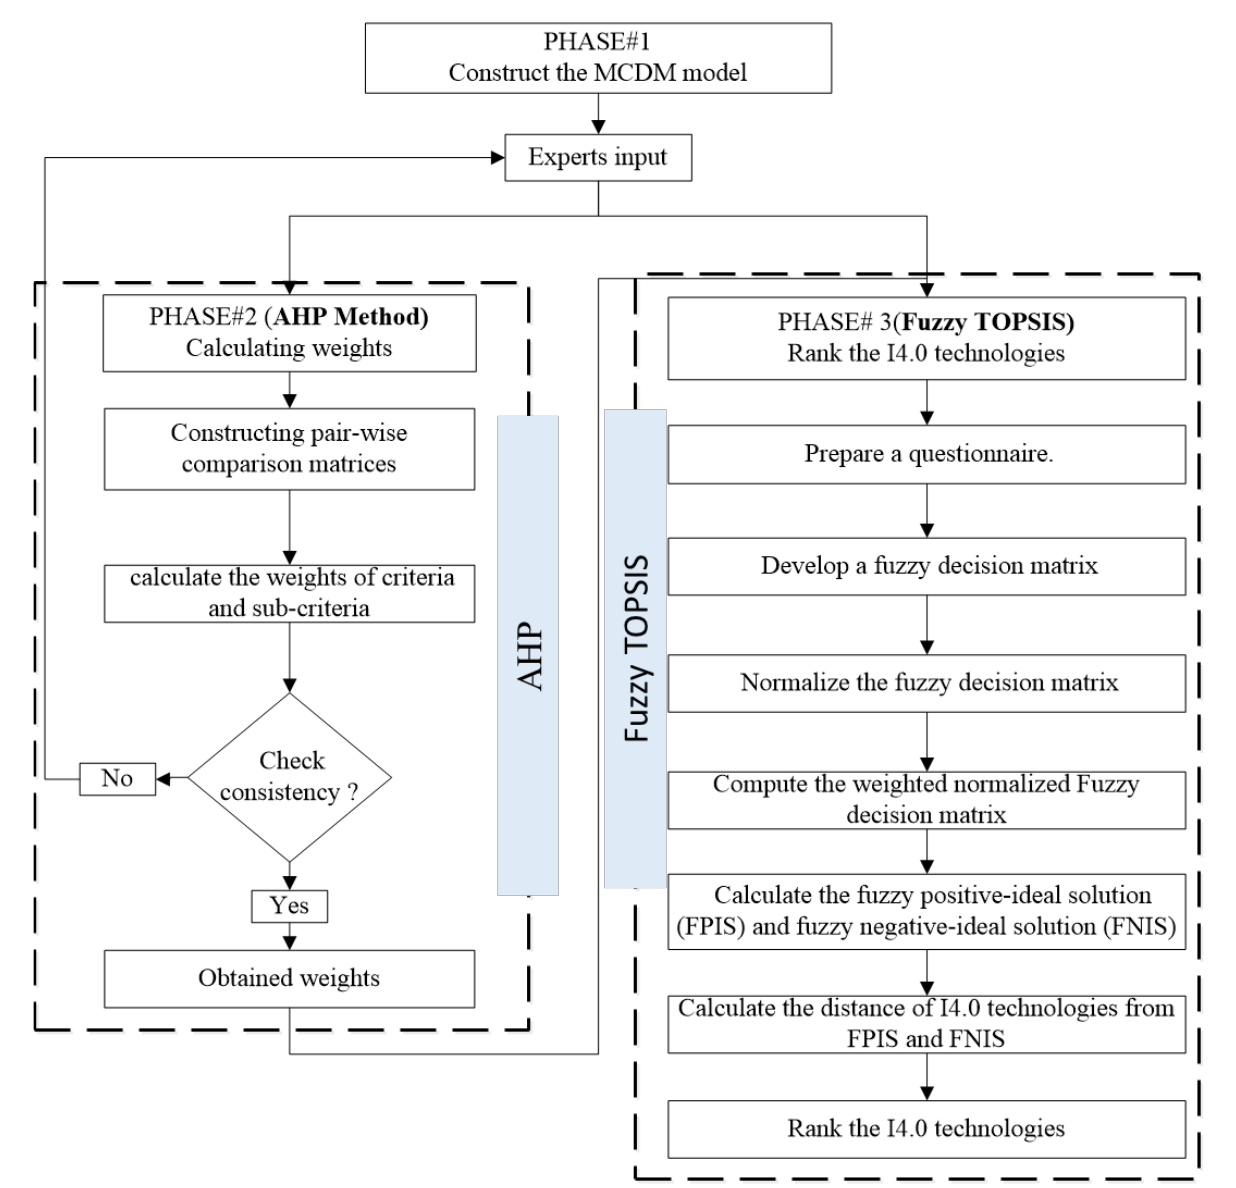
Figure 3. The proposed evaluation approach for I4.0 technologies on MSOs.